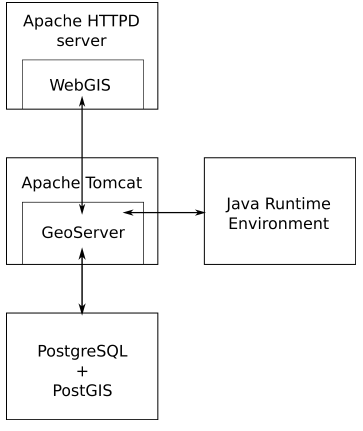
Figure 2. The software architecture of the ADA server.